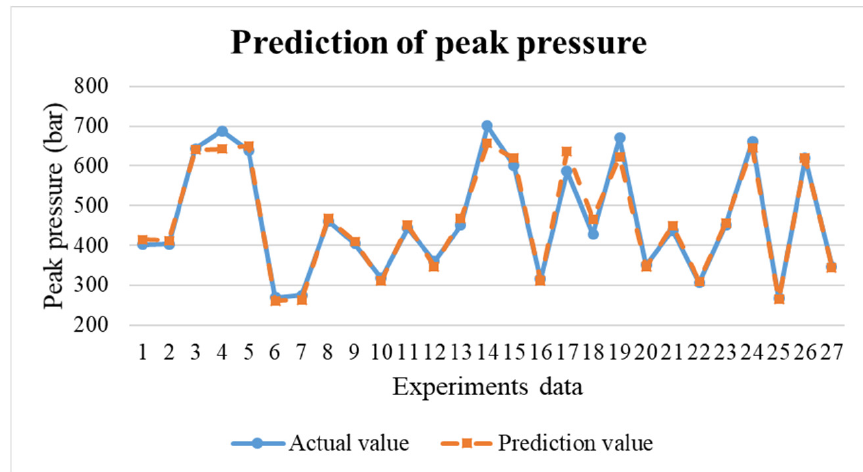
Figure 18. Prediction results of peak pressure. Table 3. Error of prediction